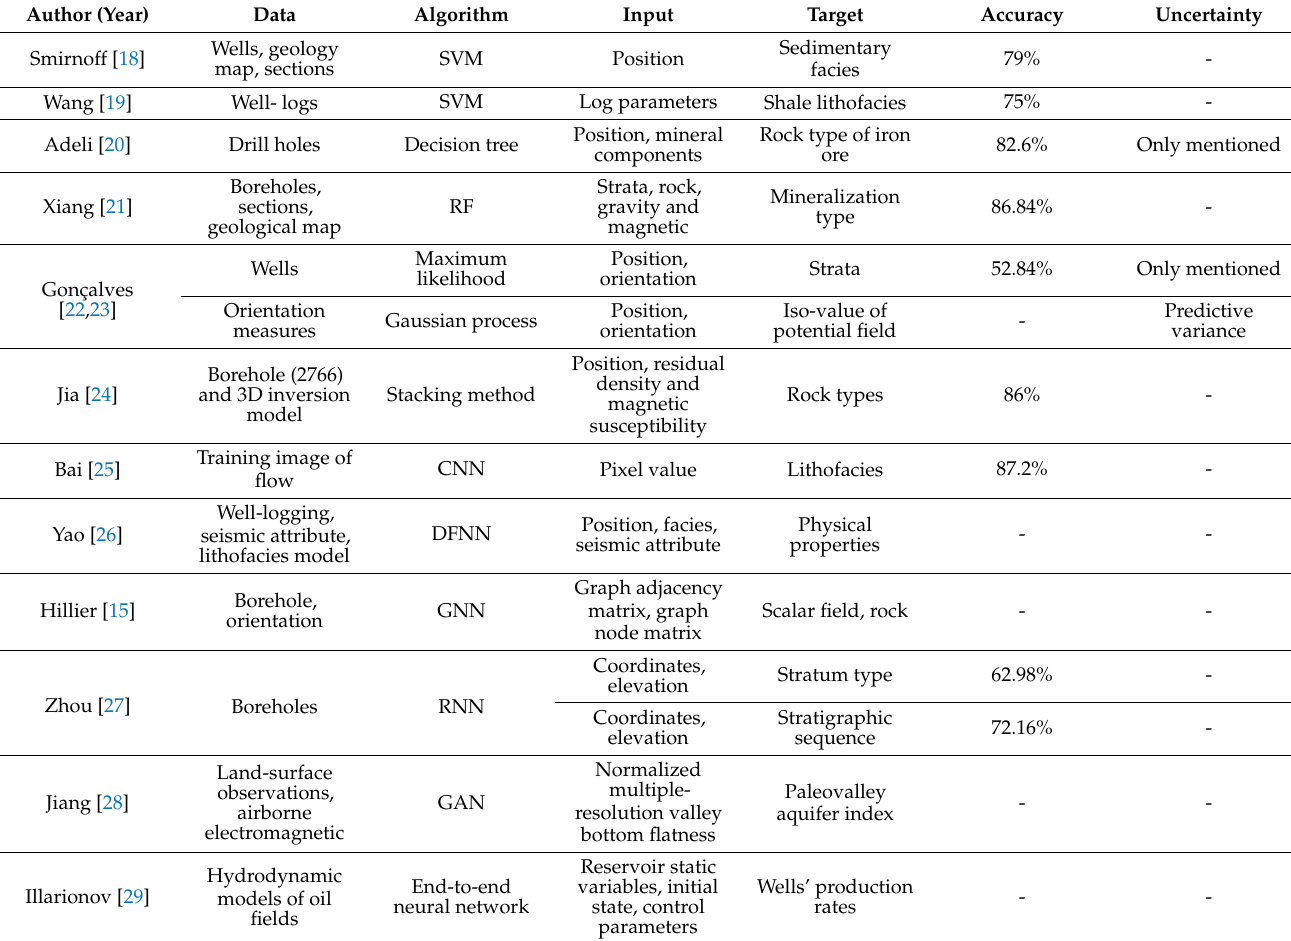
Table 1. Research on 3D geological modeling using machine